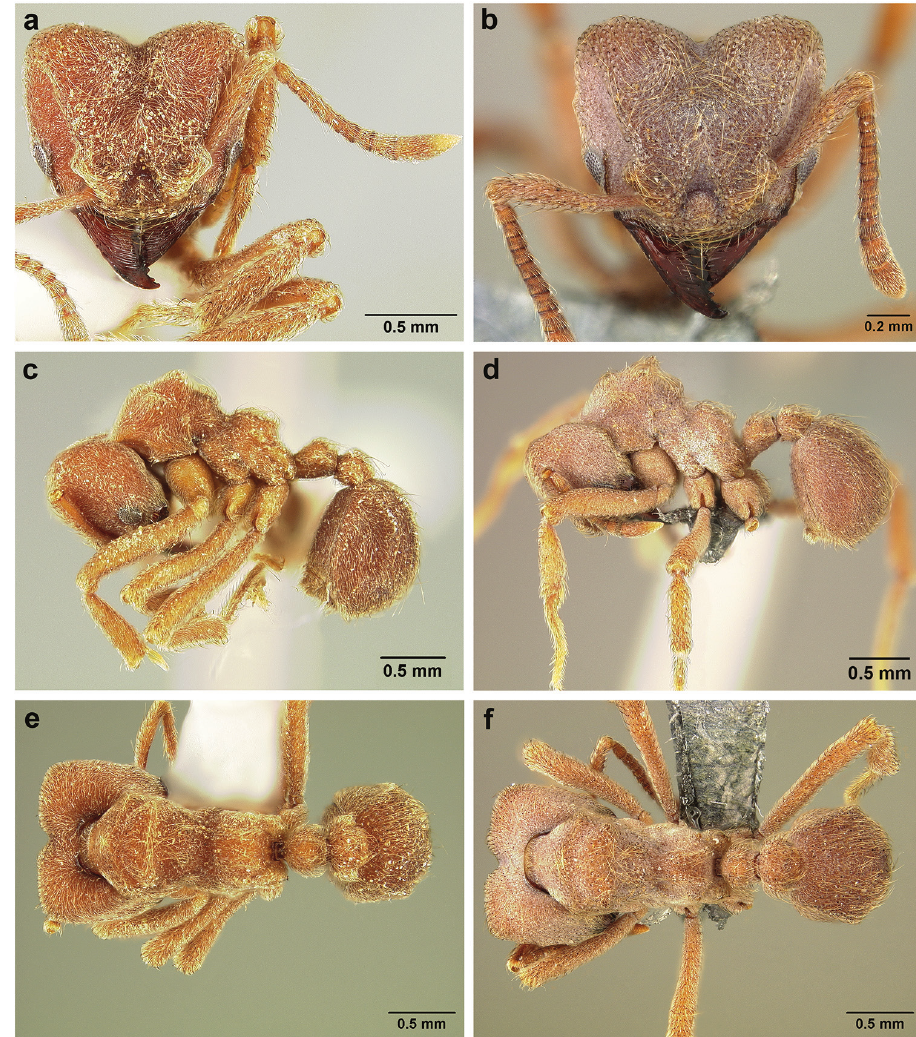
Figure 17. S. amabilis worker; head, lateral profile, and dorsal view. Striate-mandibled form (USN- MENT00308236) ( a, c, e ) Smooth-mandibled form (USNMENT01125194) ( b, d, f ).